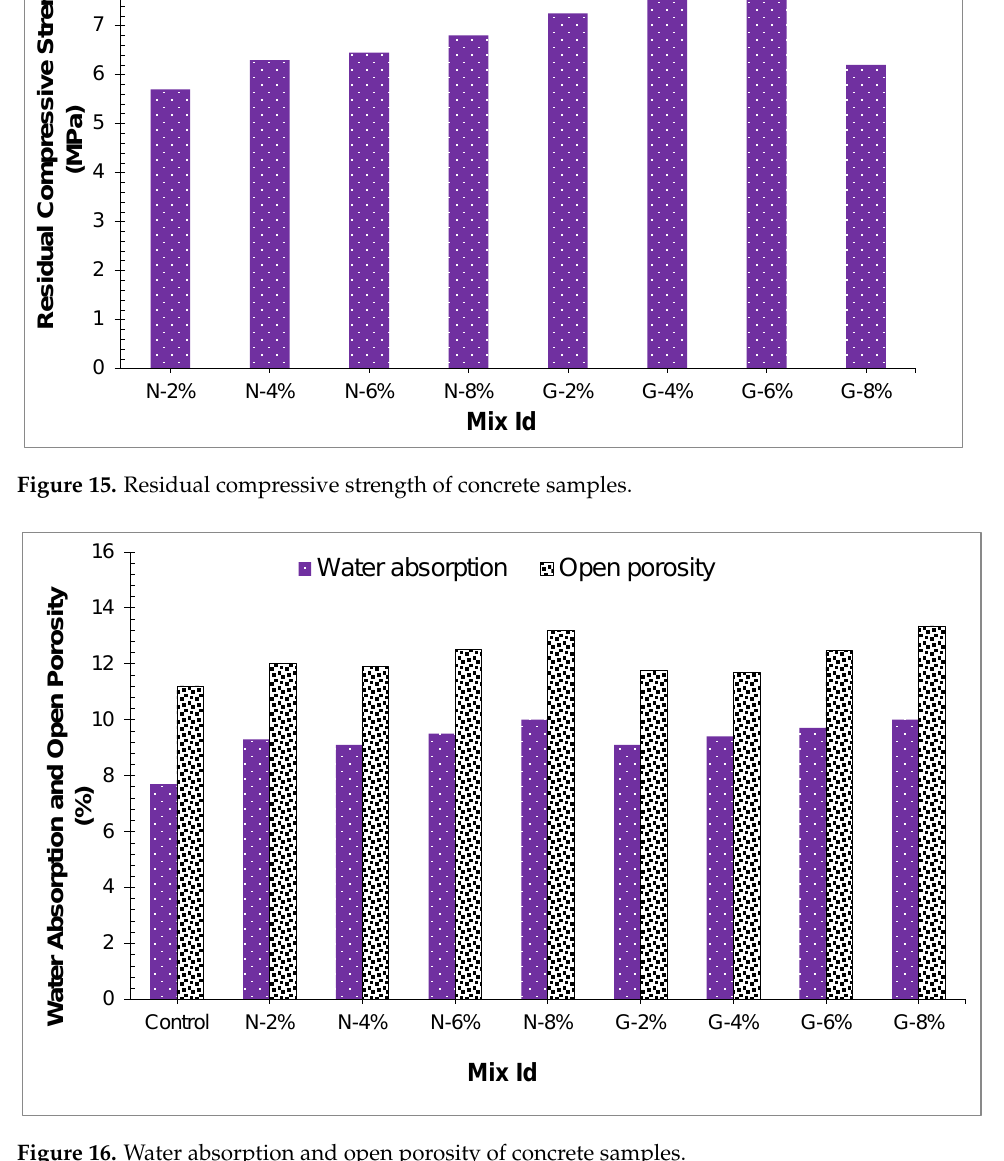
Figure 15. Residual compressive strength of concrete samples.